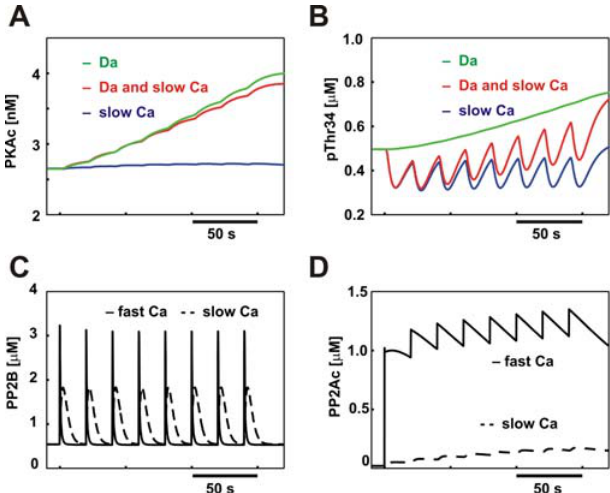
Figure 7. Consequences of Pairing Slower Calcium Signals with Dopamine Inputs (A) The cumulative increase of free PKAc following eight high-amplitude, brief dopamine inputs (green line) is a bit larger than if a slow, low- amplitude calcium signal is paired with the brief dopamine inputs (red line). Also the slower, low-amplitude calcium input alone (blue line) does not give any significant increase in PKAc. (B) Pairing slow, low-amplitude calcium inputs with dopamine inputs (red line) reduces the cumulative increase in phosphoThr34 compared with a dopamine input alone (green line). A decrease of phosphoThr34 is seen following a calcium input alone (blue line). (C) The decrease in phosphoThr34 due to the slow, low-amplitude calcium input is due to a prolonged activation of PP2B (dashed line) compared with when a brief, high-amplitude calcium input is given (solid line). (D) Furthermore, the calcium-activated form of PP2A (PP2Ac) is significantly less activated following a small but slower calcium input (dashed line) than if a high-amplitude calcium input is given (solid line). DOI: